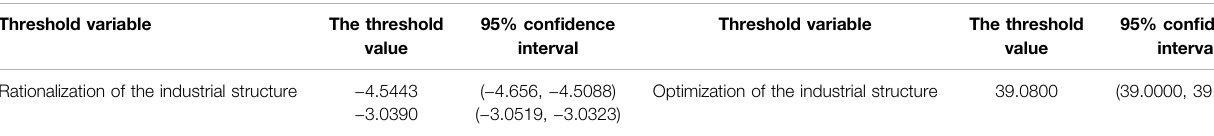
TABLE 3 | Estimated results of threshold values.